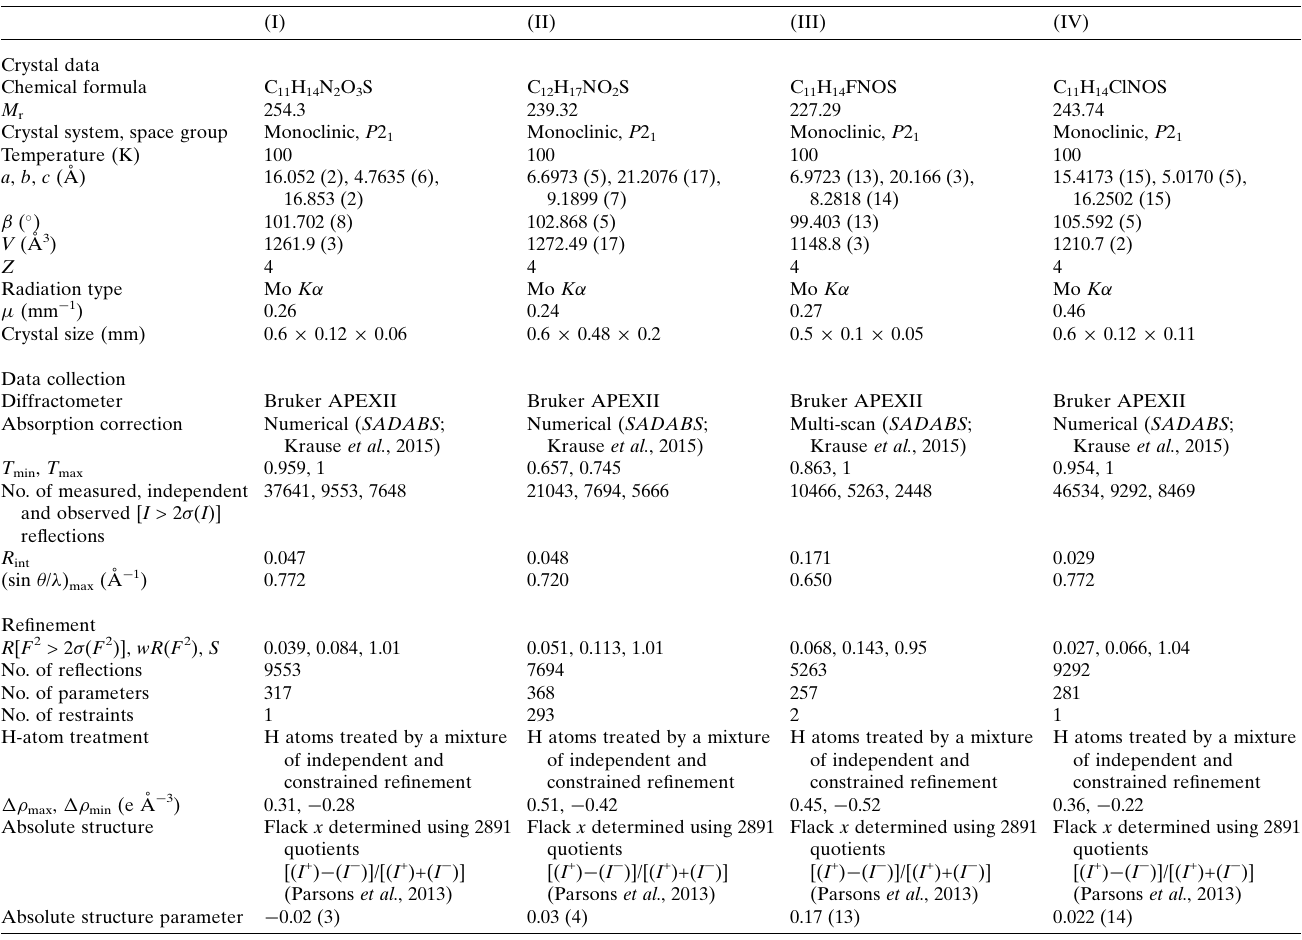
Table 5 Experimental